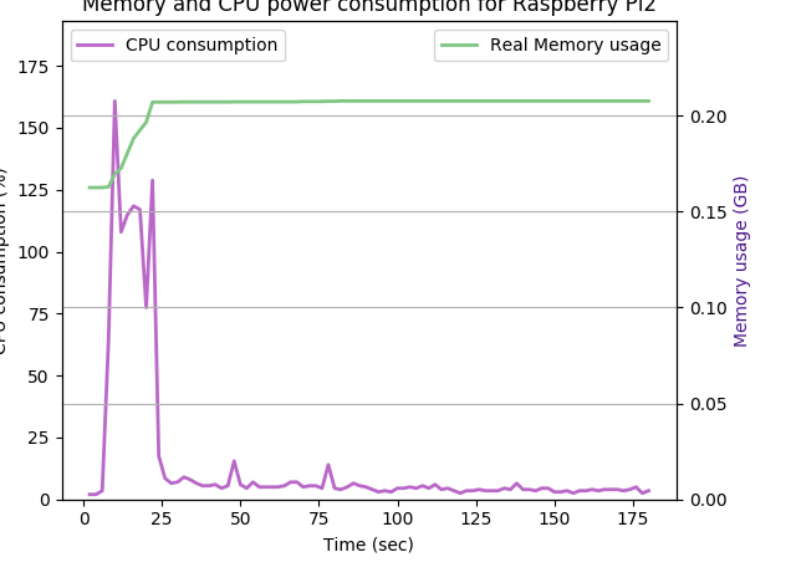
Figure 18. The CPU and memory utilization of the Raspberry Pi device using